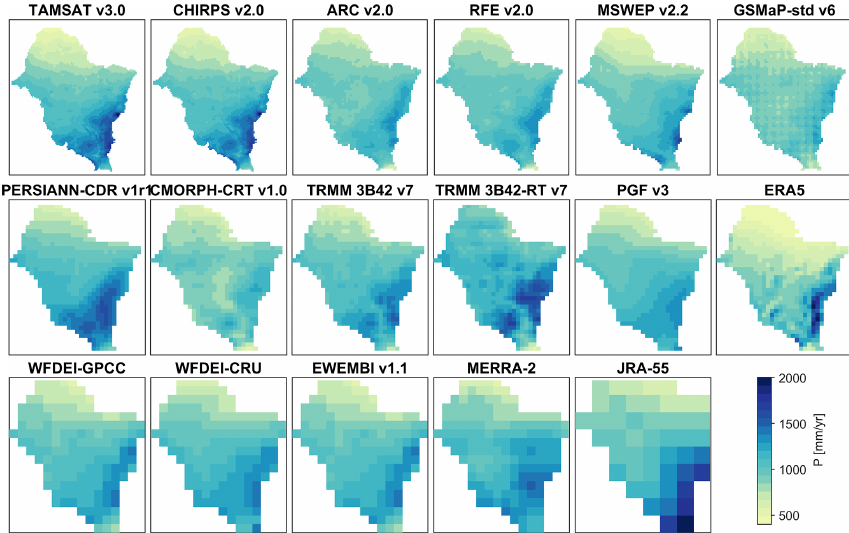
Figure A1. Mean annual rainfall totals over the period 2003–2012 for 17 rainfall datasets in the Volta River basin.